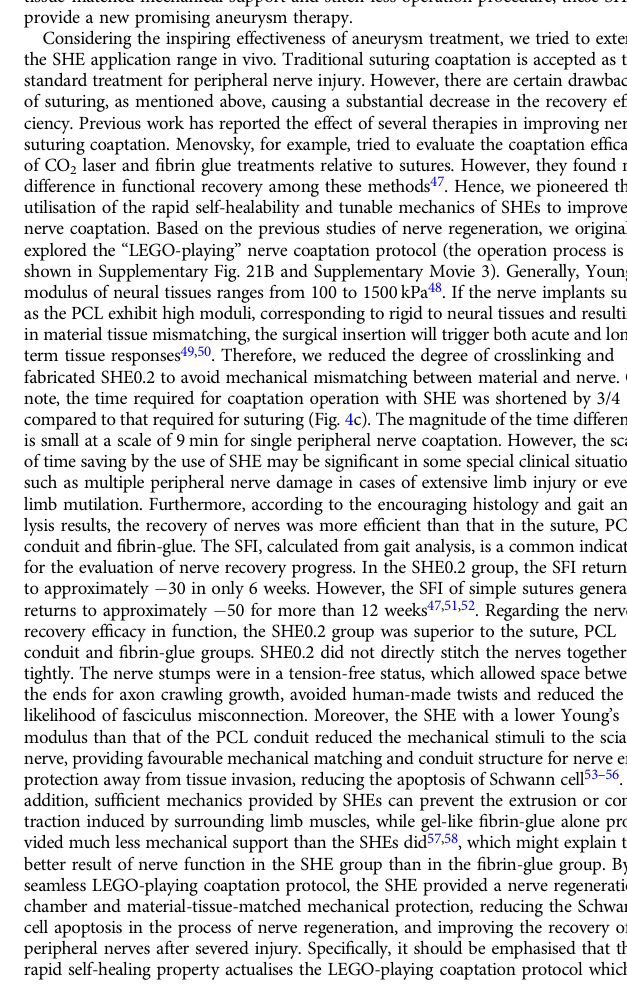
Fig. 4 Pattern diagram and paper-cut simulation of sciatic nerve coaptation, gait analysis of sciatic nerve injury model, Masson trichrome staining of gastrocnemius, immuno fl uorescence staining of regenerated nerve. a Pattern diagram shows the grouping of sciatic nerve coaptation. b Paper-cut simulations of sciatic nerve coaptation. c Statistical histogram of coaptation time during the operation ( n = 6 in each group). d Image results of gait analysis in SHE group and suture group. The green blot in the solid yellow box is the footprint of the left lower limb (injury side) of the rat. e Statistical histogram of sciatic nerve function index ( n = 5 in each group). f Masson trichrome staining on gastrocnemius in each group. Red part of staining is muscle fi bres while blue part is collagen in muscle, scale bar = 100 μ m. g Statistical plot of the average diameter of gastrocnemius fi bres in each group ( n = 5 in each group). h Statistical plot of muscle weight ratio (ipsilateral to contralateral) in each group ( n = 5 in each group). i Hematoxylin – eosin staining of distal anastomotic sciatic nerve. The capillaries inside the nerve bundle are pointed by yellow* ( n = 5 in each group), scale bar = 100 μ m. j Statistical plot of capillary quantity per section in sham, SHE and suture group ( n = 5 in each group). k Immuno fl uorescence staining of S100 (red), NF200 (green) and ChAT (red) of distal anastomotic sciatic nerve in SHE group and suture group, scale bar = 100 μ m. l through m Statistical plot of S100 and NF200 expression, respectively, per section in sham, SHE and suture group ( n = 5 in each group). n Statistical plot of axon quantity per section (/mm 2 ) in sham, SHE and suture group ( n = 5 in each group). Data were presented as mean ± s.d. Two-tailed unpaired t test ( c , e ) was used for comparing anastomosis time and sciatic nerve function index (SFI) between SHE and Suture group. Anastomosis time ( c ): SHE group compared to Suture group, **** p < 0.0001; SFI ( e ): SHE group compared to Suture group, **** p < 0.0001. Ordinary one-way ANOVA test with Tukey ’ s multiple comparisons test ( j , l , g , h , m , n ) was used for analysis of capillary quantity, S100 expression, NF200 expression, muscle fi bre diameter and muscle weight ratio. Capillary quantity ( j ): Sham compared to SHE, ns p = 0.9608; Sham compared to Suture, ns p = 0.9032; SHE compared to Suture, ns p = 0.9857; Diameter of muscle fi bres ( g ): Sham compared to SHE, ns p = 0.6865; Sham compared to Suture, ns p = 0.6462; Sham compared to Defect, **** p < 0.0001; Sham compared to Suture, ns p = 0.1405; SHE and